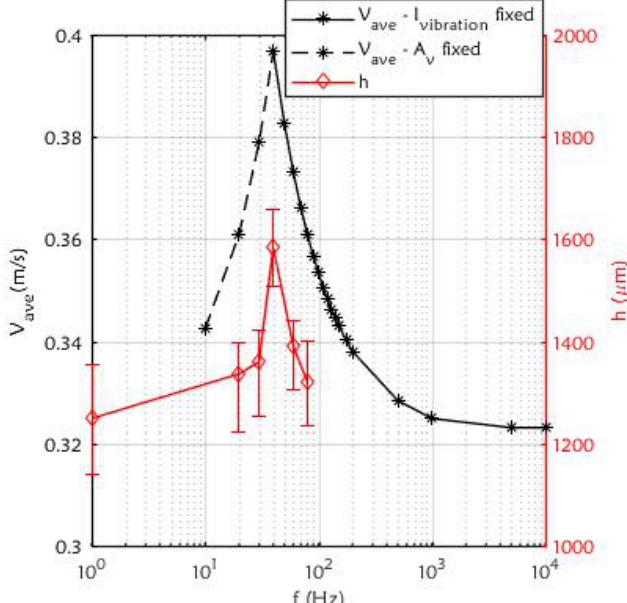
Figure 10: Relationship between average flushing speed and machining